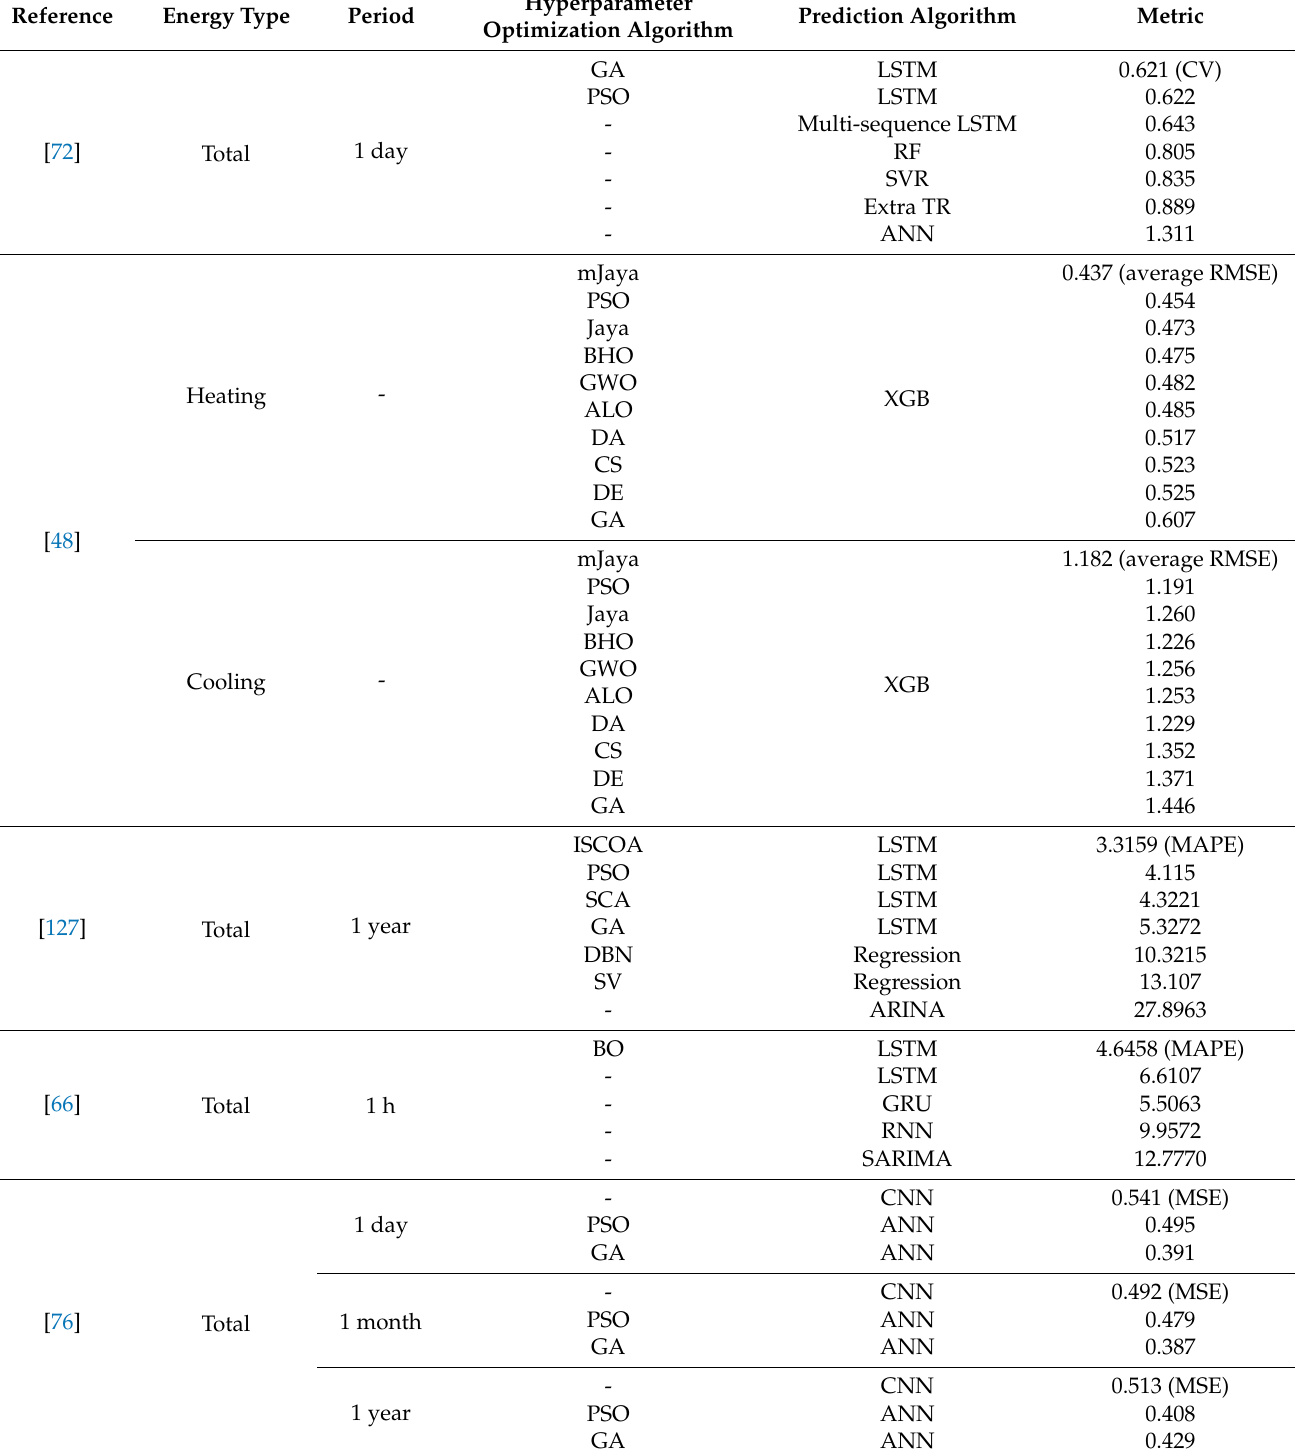
Table 5. Comparative accuracy of different hyperparameter optimization